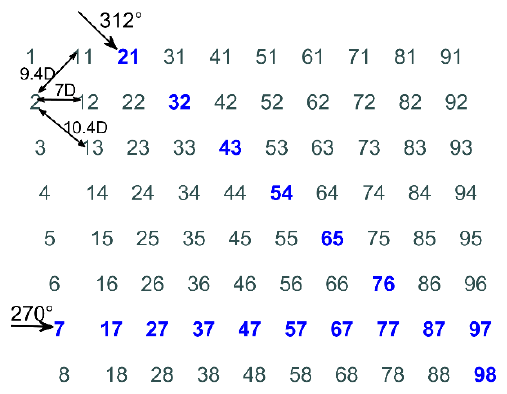
( b ) Figure 8. Horns Rev I power deficit in ( a ) a row with 7D spacing and 270 ± 2°, and ( b ) a row with 10.4D spacing and 312 ± 2°. When the wind directions are 270° and 312°, the spacing between two turbines undergoes a minimum value of 7D and a maximum value of 10.4D, respectively. Observing the power deficit of the second turbine in Figure 8, there is a large discrepancy when comparing numerical simulations